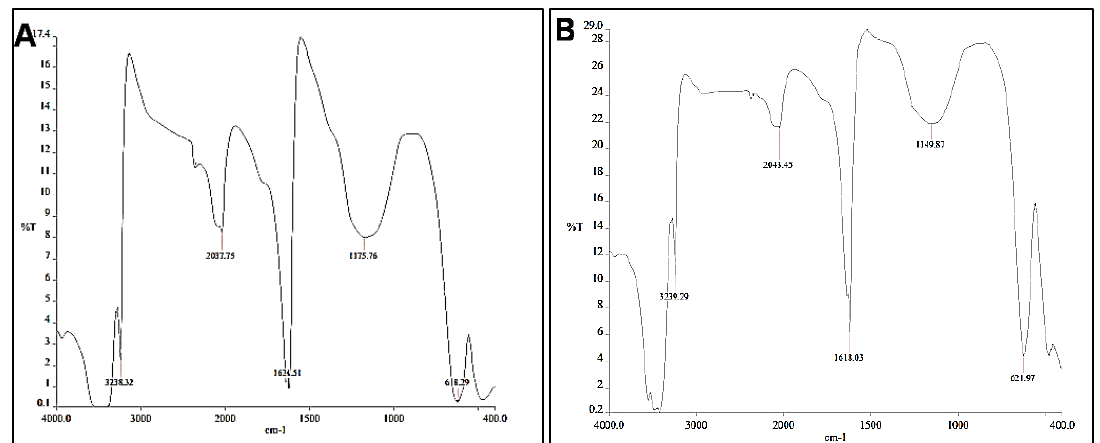
Figure 4. FTIR spectra of bio-synthesized Ag-NPs ( A ); A.biebersteinii extract ( B ).